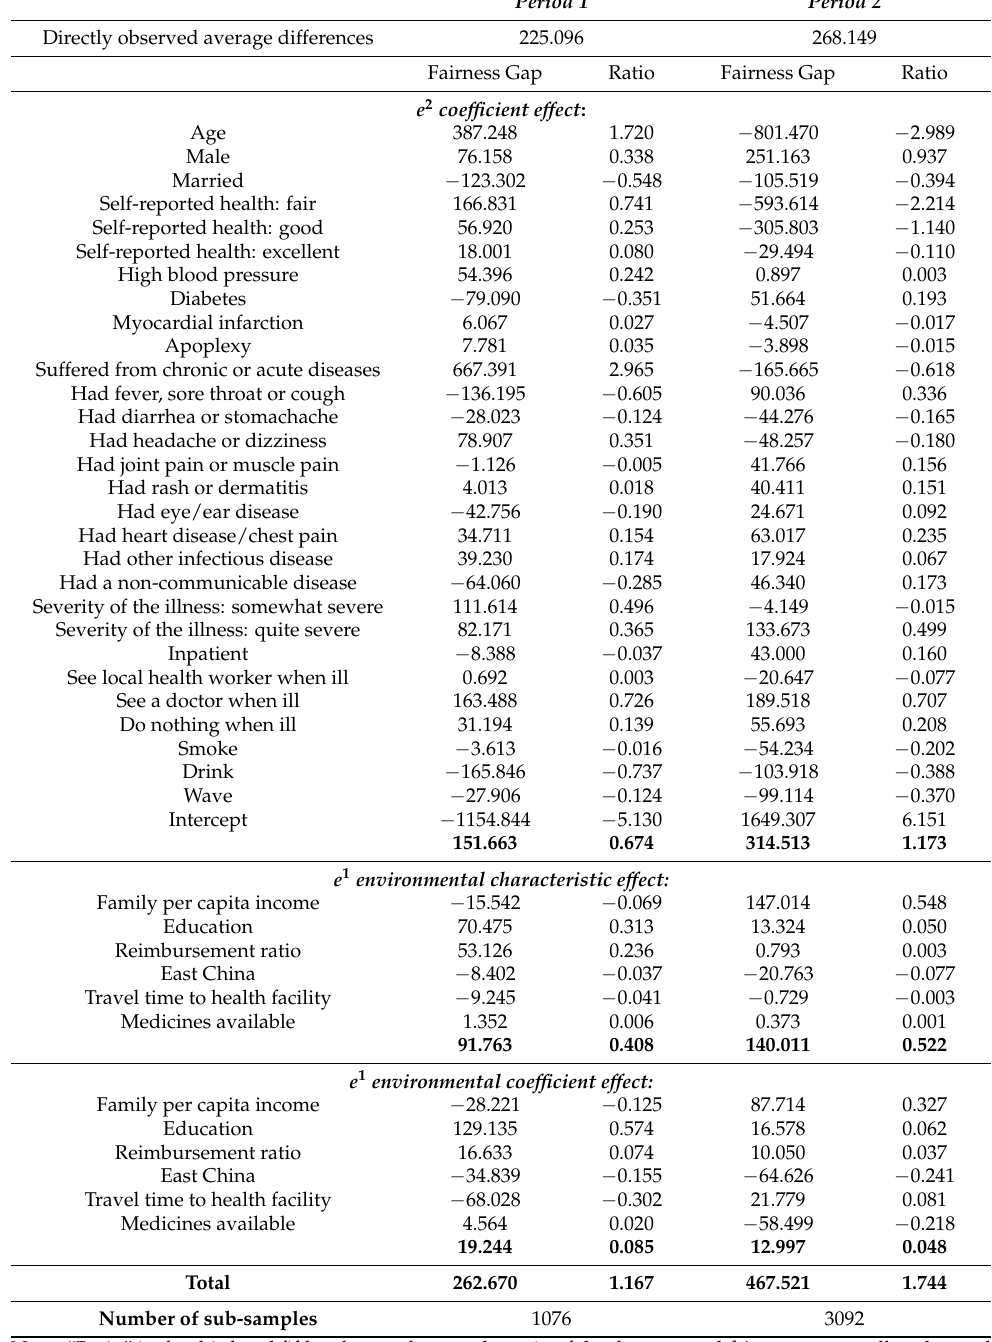
Table 2. Decomposition of Fairness Gaps Using CHNS